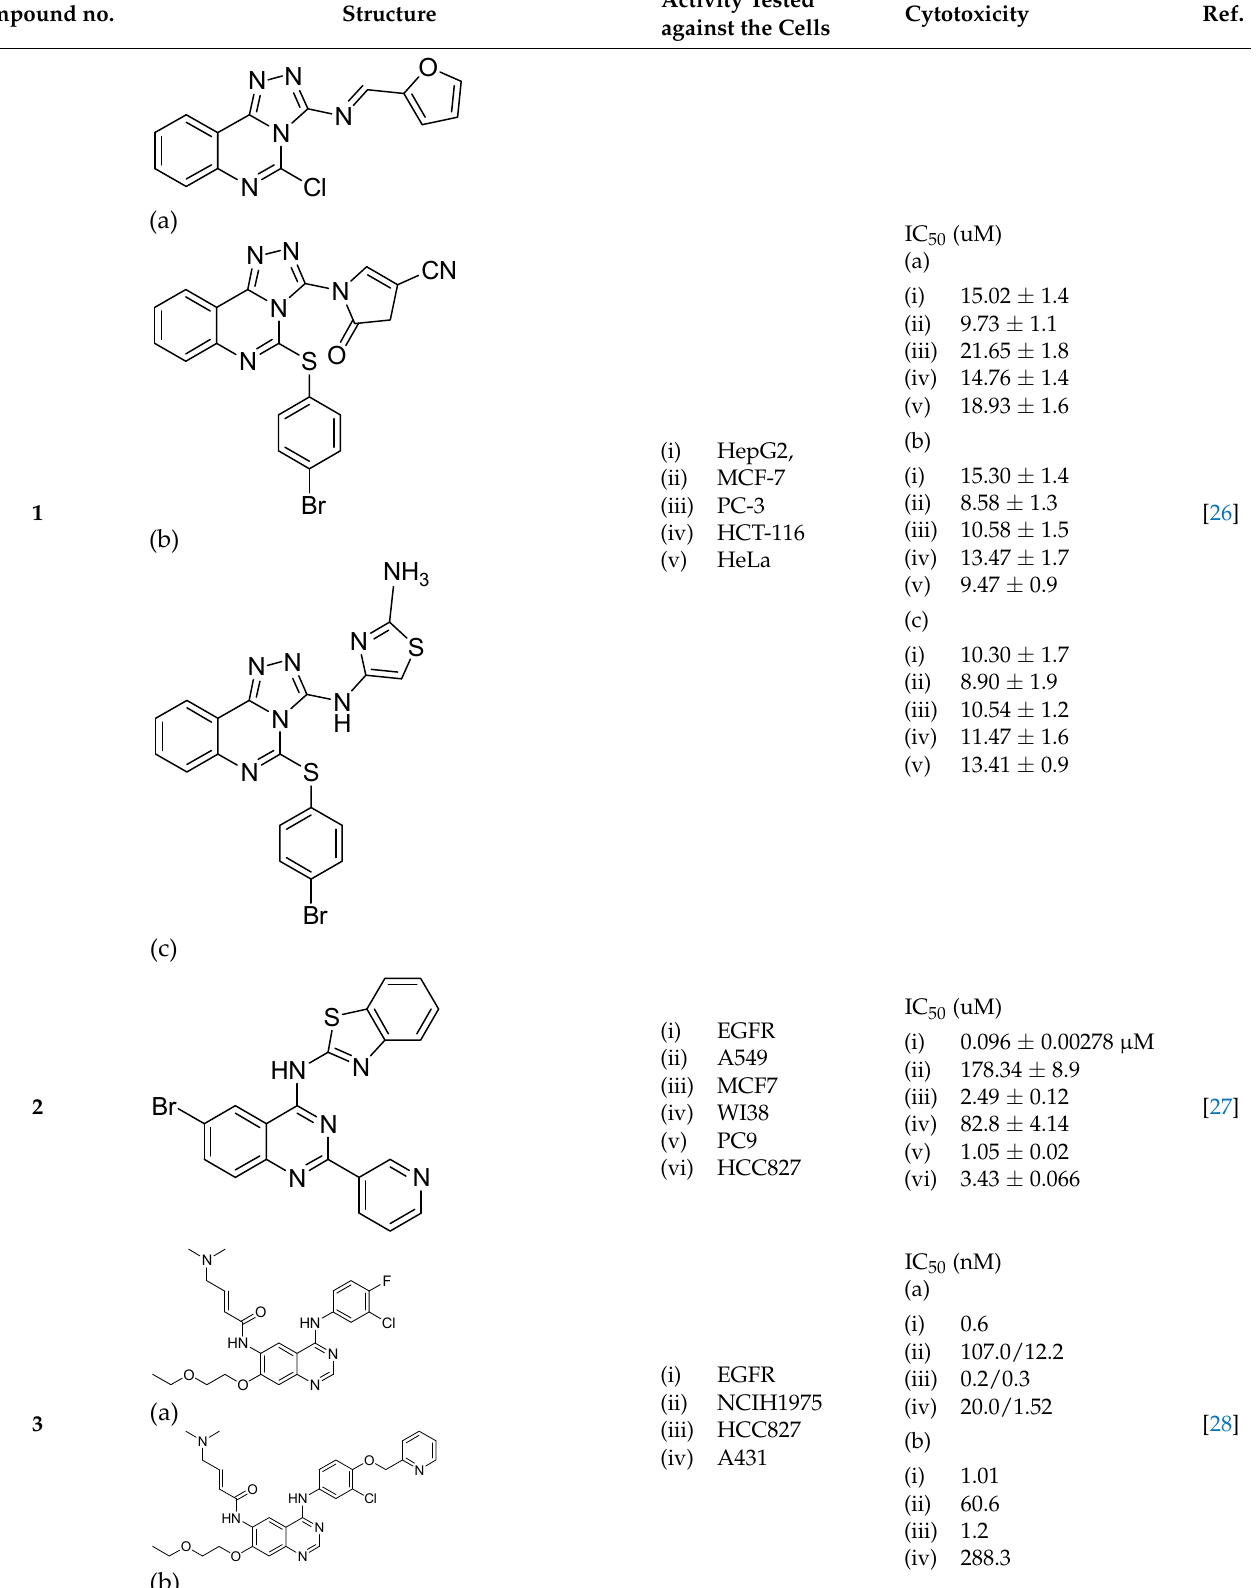
Table 2. Quinazoline based anti-tumor agents. Activity Tested Cytotoxicity Ref. against the Cells